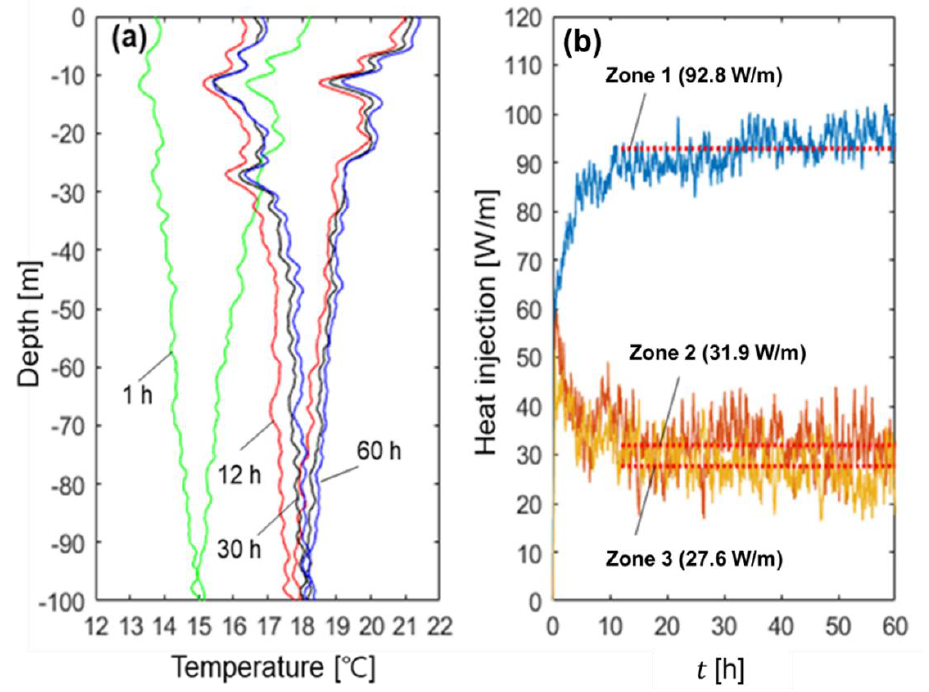
Figure 9. ( a ) Vertical temperature distribution during the heat injection period, and ( b ) the heat transfer rate of each